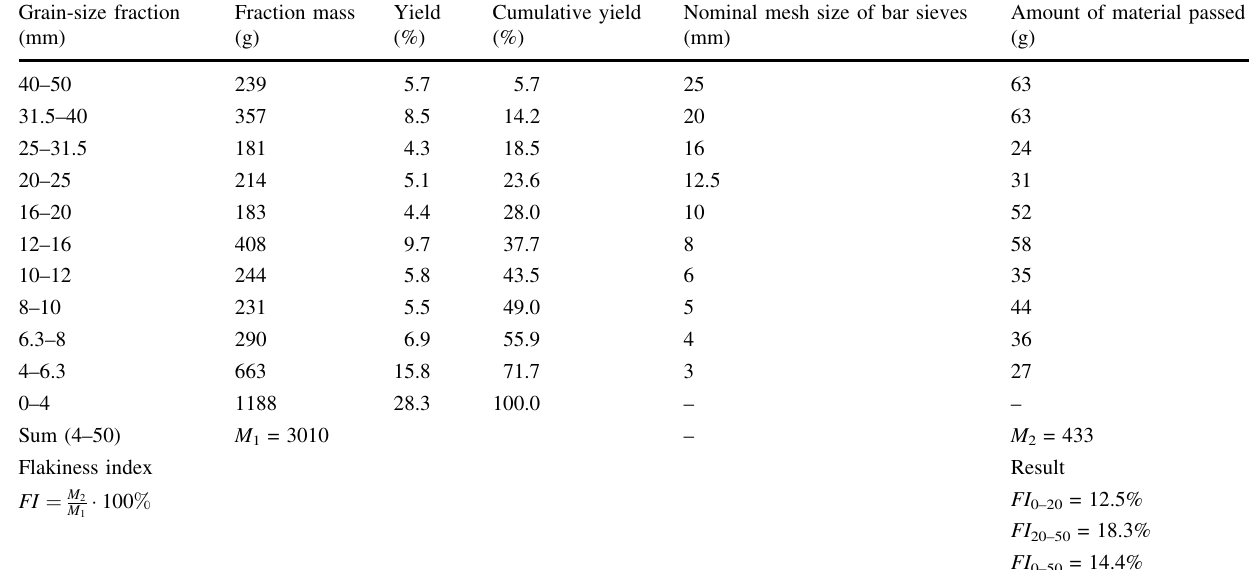
Table 3 Sieving and flakiness-index analysis results for coal No. 1